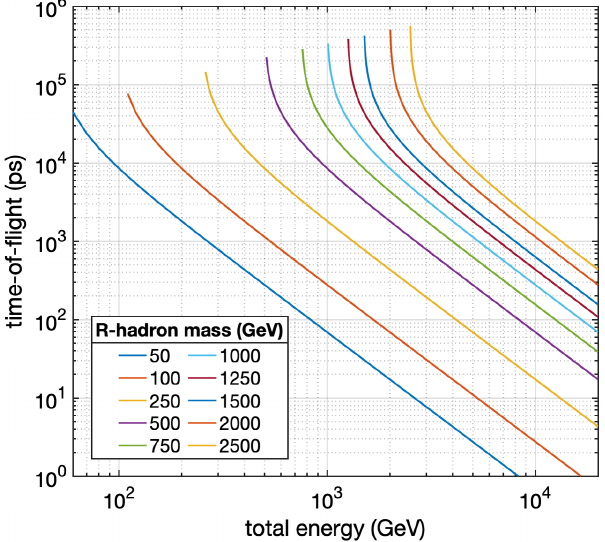
FIG. 31. TOF for a heavy stable beyond-standard-model charged particle, in this case, the result of R -hadronization of a pair-produced top squark, as a function of the total particle energy, including the masses indicated in the